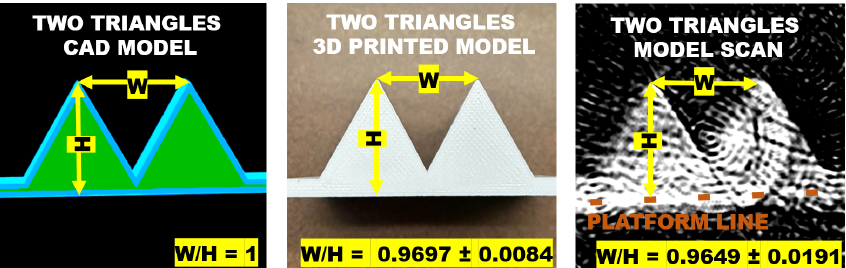
Figure 11. Width and height ratio of the Two Triangles model scan is compared to the same ratio of its 3D printed